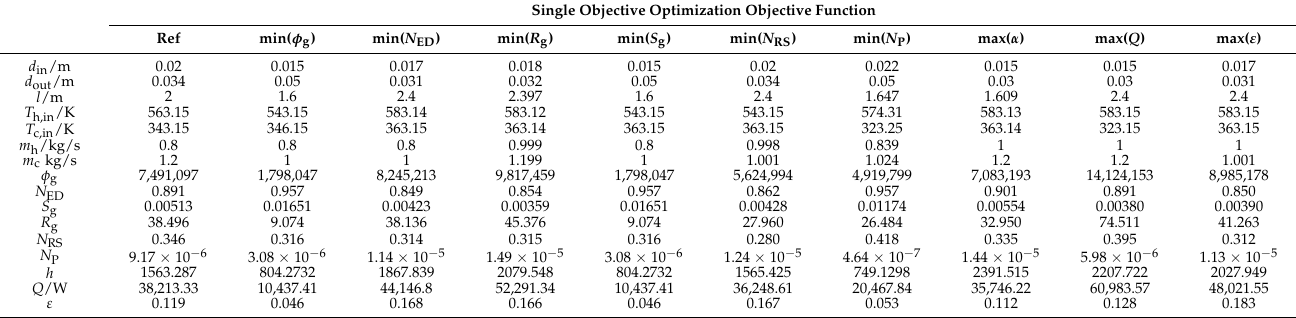
Table 4. Single-objective optimization calculation